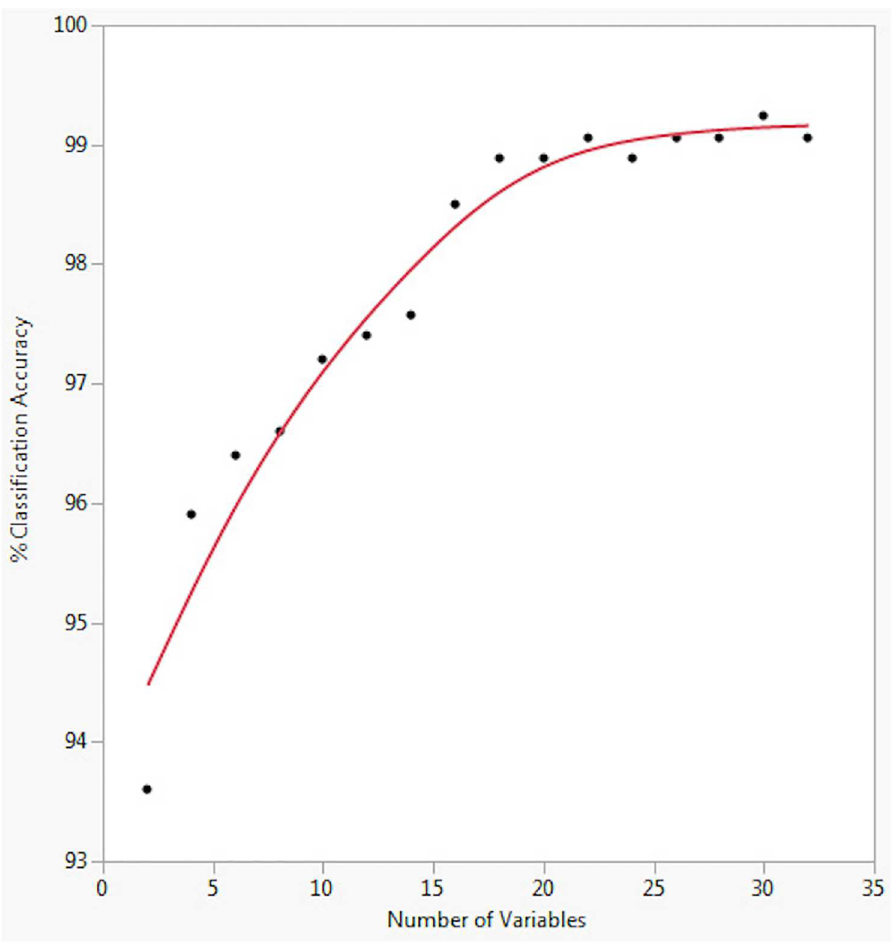
Fig 10. The relationship between the number of variables used to classify by sex and the resulting percentage accuracyof classification, from which 20 was identified as an optimal